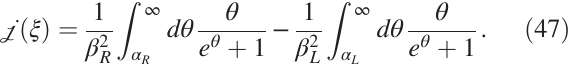
0 , that is, L;R ¼